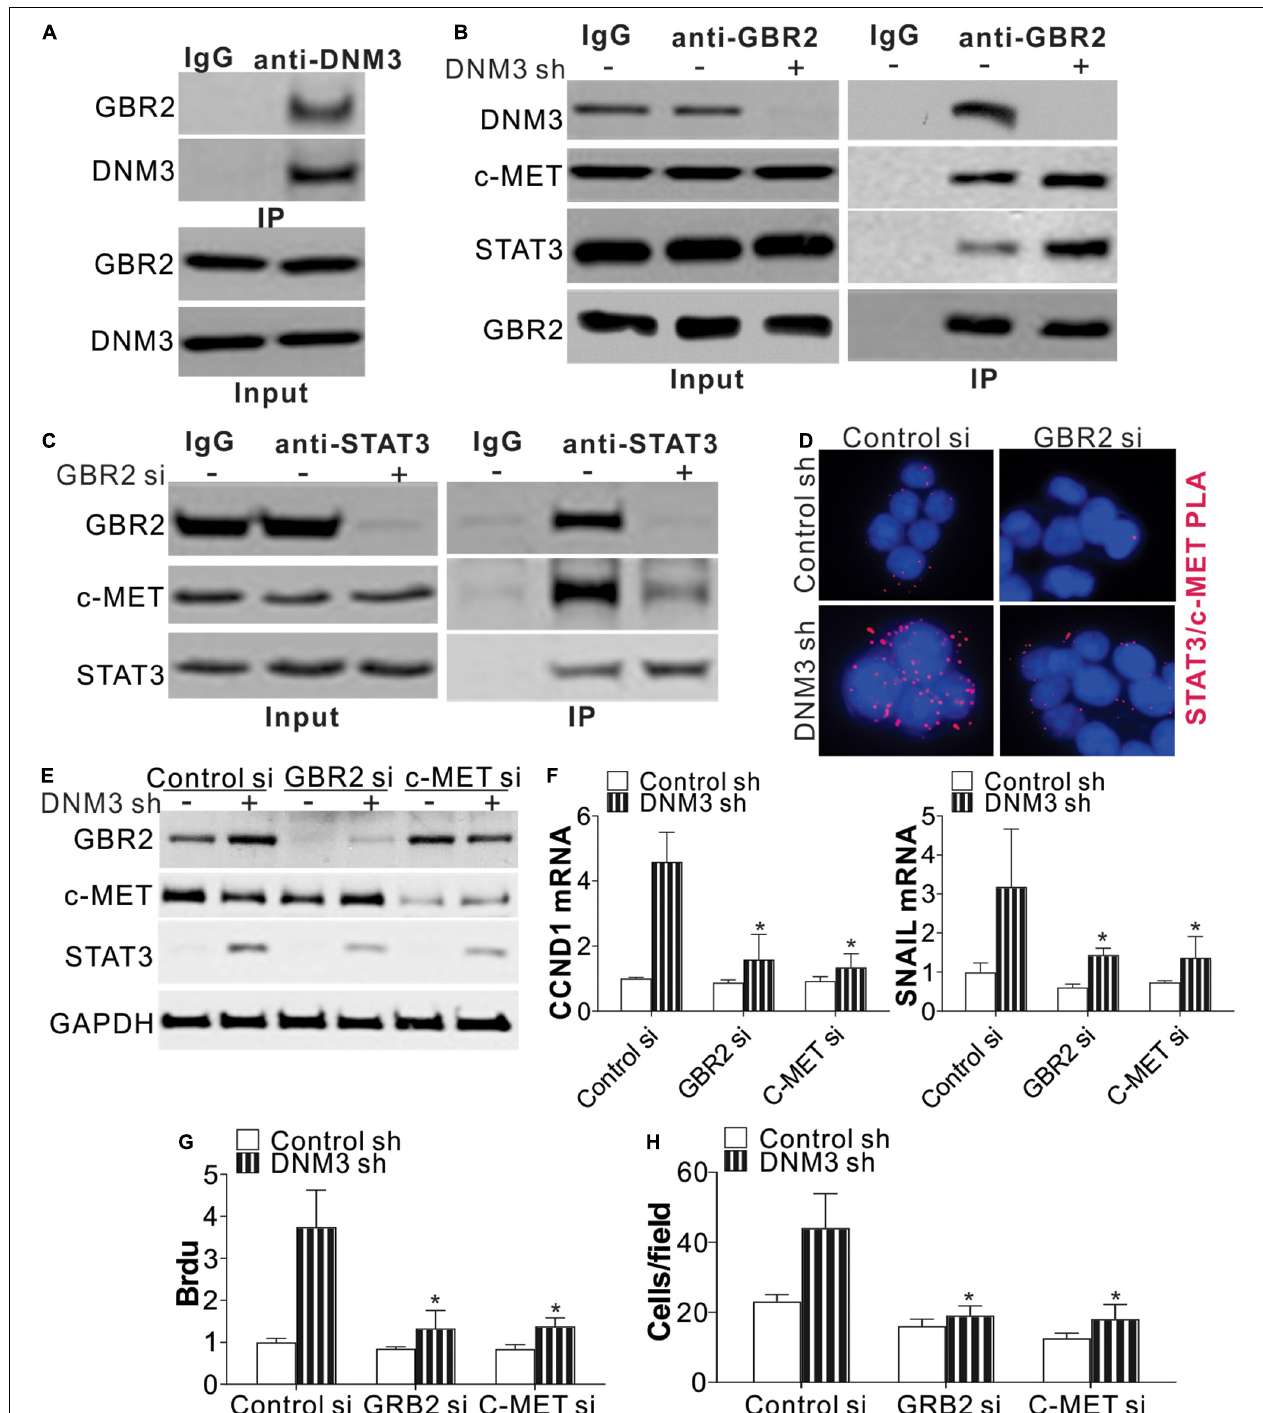
FIGURE 5 | DNM3 interacts with GBR2 to suppress the latter’s binding with STAT3 and c-MET. (A) Immunoprecipitation assay of the interaction between DNM3 and GBR2, using anti-DNM3 antibody. (B) Interaction among GBR2, STAT3, c-MET, and DNM3 in H1299 cells with or without DNM3 knockdown. (C) Interaction of STAT3 and c-MET with GBR2 in H1299 cells transfected with control or GBR2 siRNA. (D) H1299 cells with or without stable DNM3 knockdown were transfected with control or GBR2 siRNA. The interaction of STAT3 with c-MET was analyzed by proximity ligation assay. (E–H) H1299 cells with or without stable DNM3 knockdown were transfected with control, GBR2 , or c-MET siRNA. (E) Western blot assay of the indicated proteins. (F) RT-qPCR assay of the mRNA expression of CCND1 and SNAI1 . GAPDH was used as reference gene. (G) Brdu assay of cell proliferation. (H) Transwell assay of the migration of the cells. Each experiment was repeated 3 times. * p <